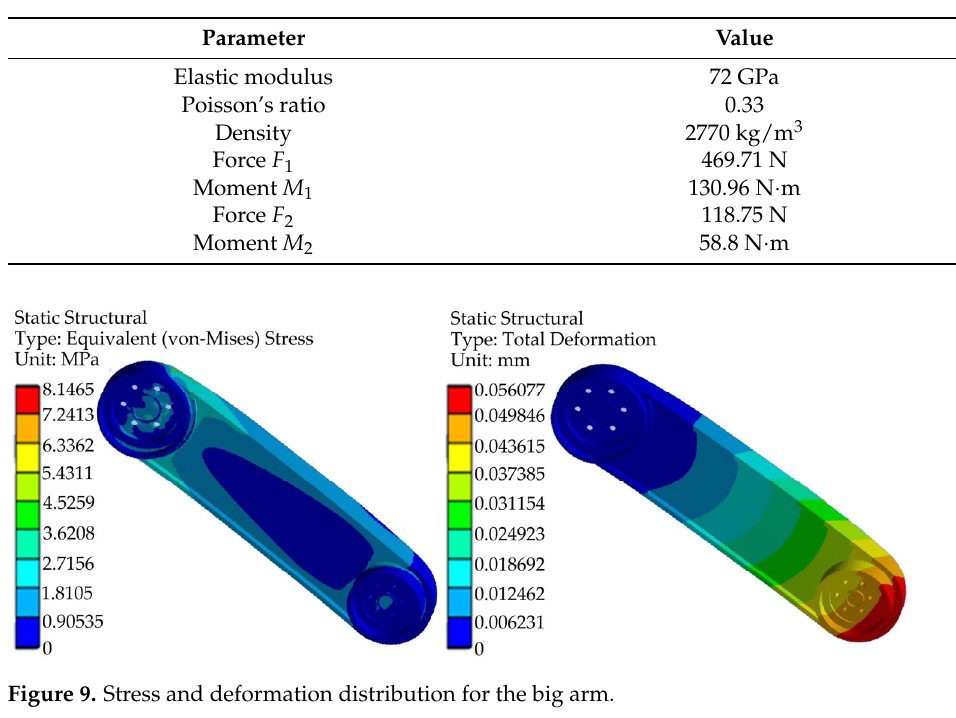
Table 2. Distribution of the uncertainties.